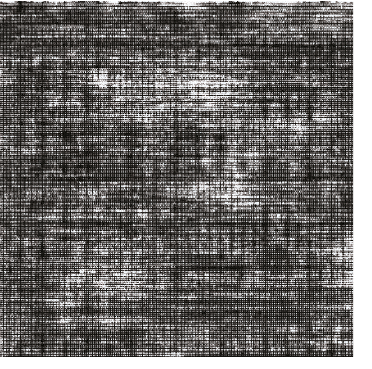
Figure 9: The reconstructed Peppers image by using r − 1 valid shadow images in the case of ( r = 2, m = 4).